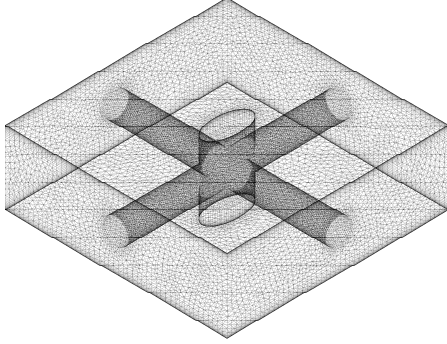
Figure 5. The computational grid for the pillar-like feed spacer.